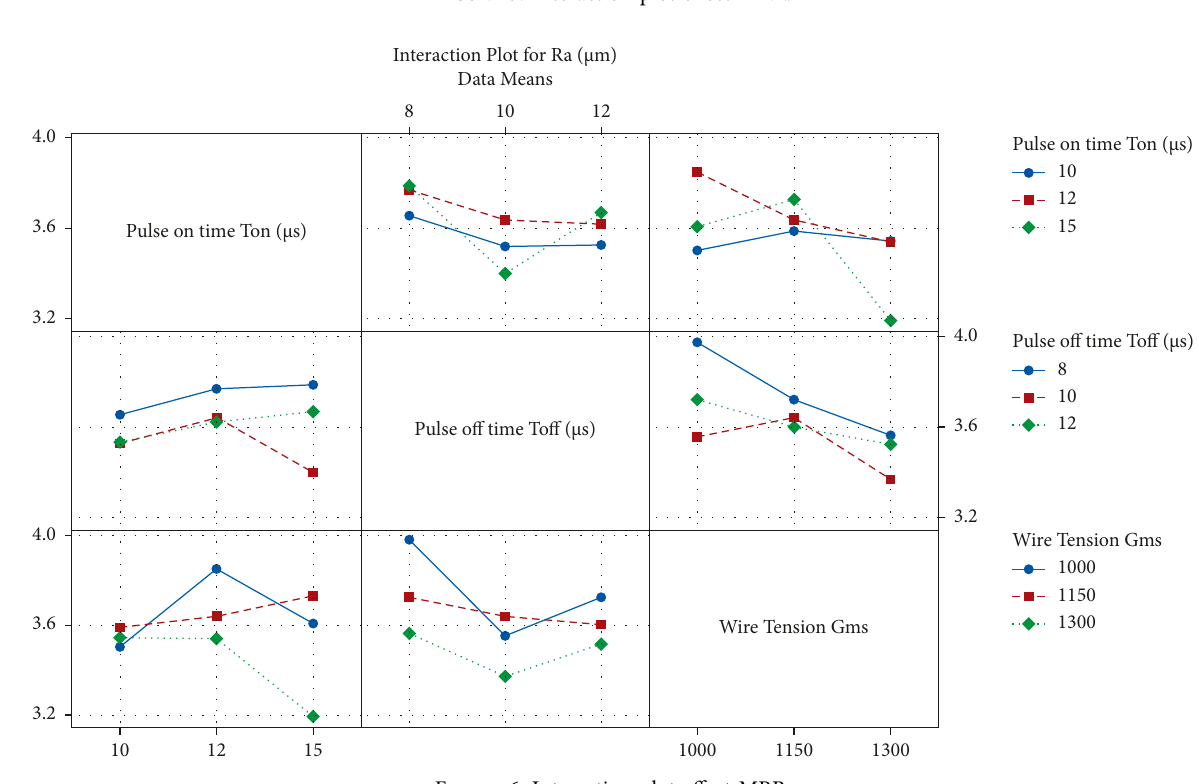
Figure 5: Interaction plot effect MRR.